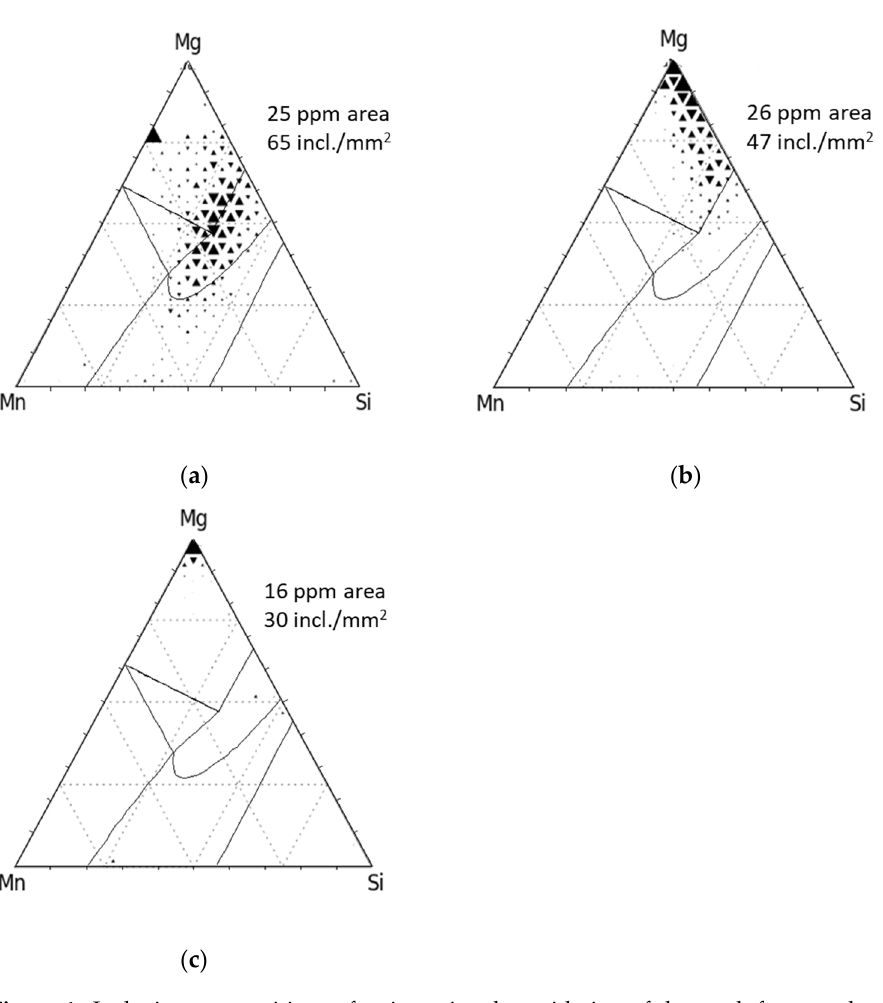
Table 3. XRF analysis results (as cation wt%) of oxide slag before and after the experiment. Figure 4. Inclusion compositions after intentional reoxidation of the steel, for samples taken ( a ) 10,820 s after slag addition, immediately after reoxidation; ( b ) 11,360 s after slag addition, 600 s after reoxidation; ( c ) 10,820 s after slag addition, 960 s after reoxidation.